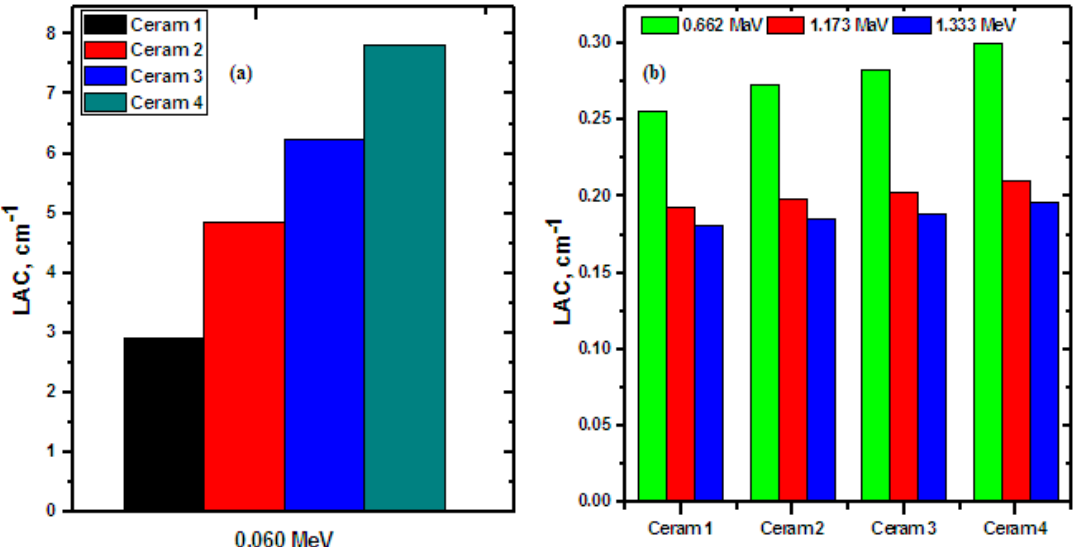
Figure 5. Linear attenuation coefficients for the prepared ceramic samples, ( a ) at 0.060 MeV and ( b ) at 0.662, 1.173 and 1.333 MeV.